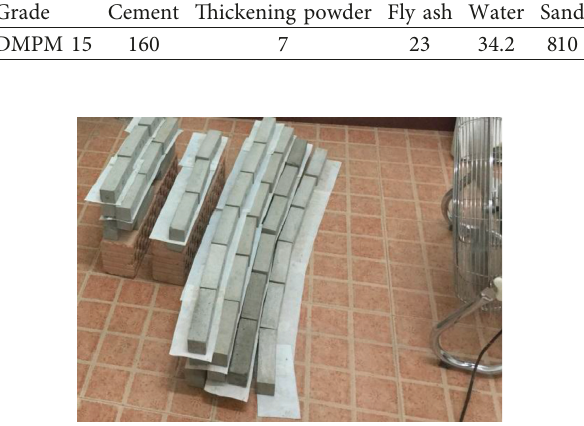
Figure 1: Water loss rate test of the DMPM prism specimen.